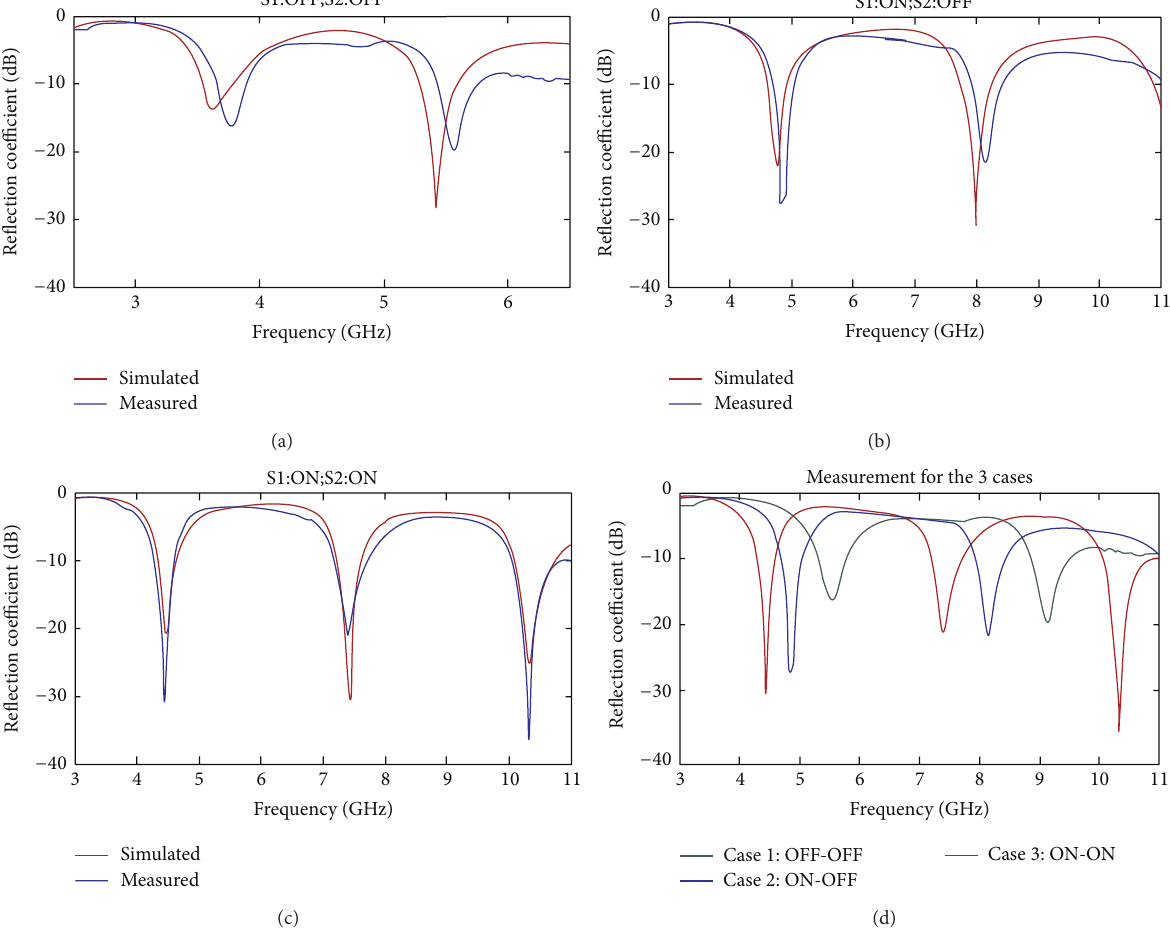
Figure 9: Reflection coefficient for 3 selected switching cases of the antenna in Figure